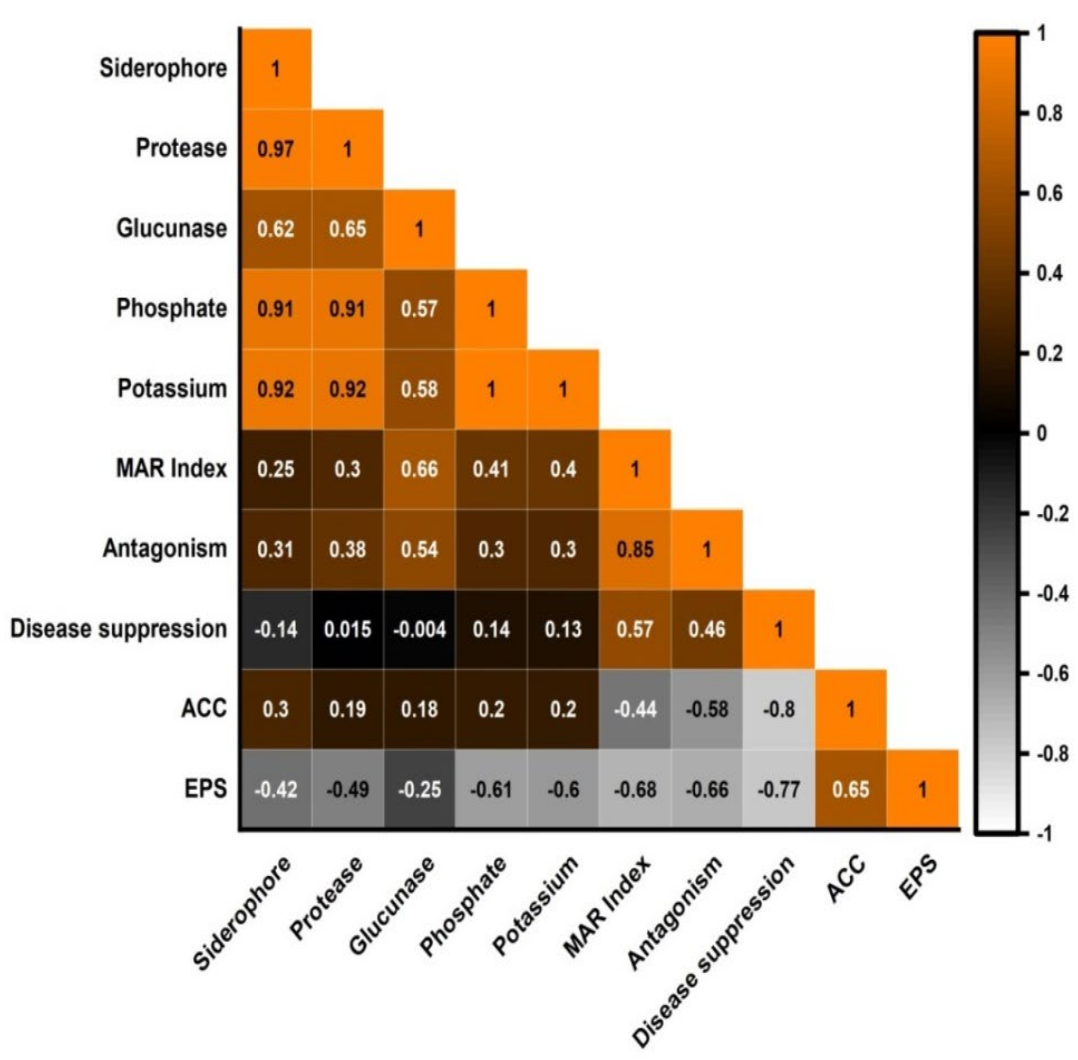
Figure 4. Correlation between MAR index and PGPR traits. ACC, 1-aminocyclopropane-1-carboxylic acid; EPS, exopolysaccharides; MAR index, multiple antimicrobial resistance index.